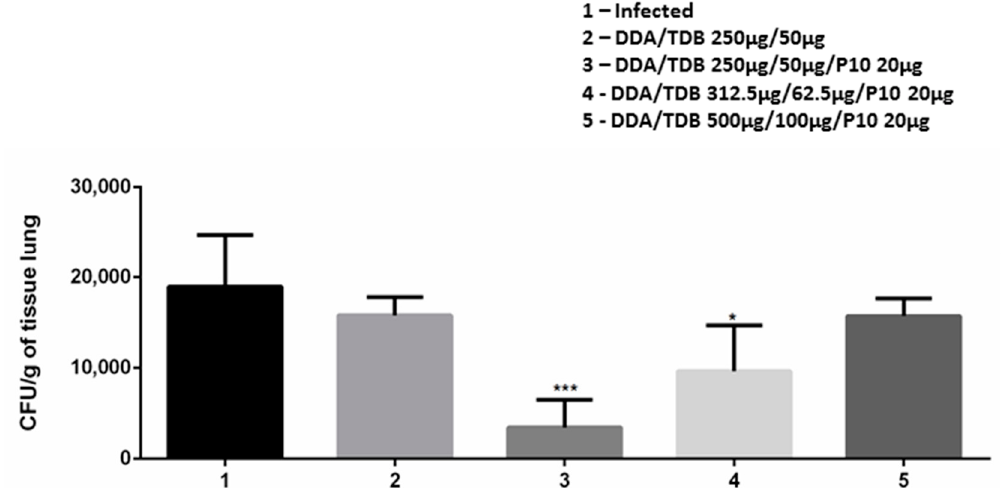
Figure 2. Vaccination with DDA/TDB/P10 decreases the fungal load. The fungal burden was measured in the lungs of mice infected with P. brasiliensis via Colony Forming Units (CFU) assay and the results were expressed as CFU/g of lung tissue. Infected animals either received PBS (1), DDA/TDB alone (2), or different formulations of DDA/TBD with P10 (3, 4, and 5). The data represent the mean and SD of results from 3 experiments using 6 mice per group. An asterisk (*) represents a statistically significant difference, *** p < 0.001 and * p < 0.05.